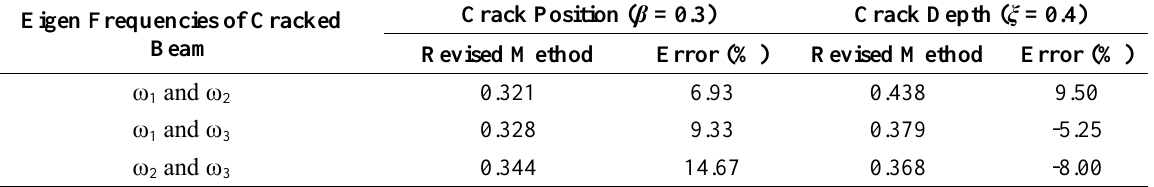
Table 4. Crack parameters obtained from proposed method (tensile load) Eigen Frequencies of